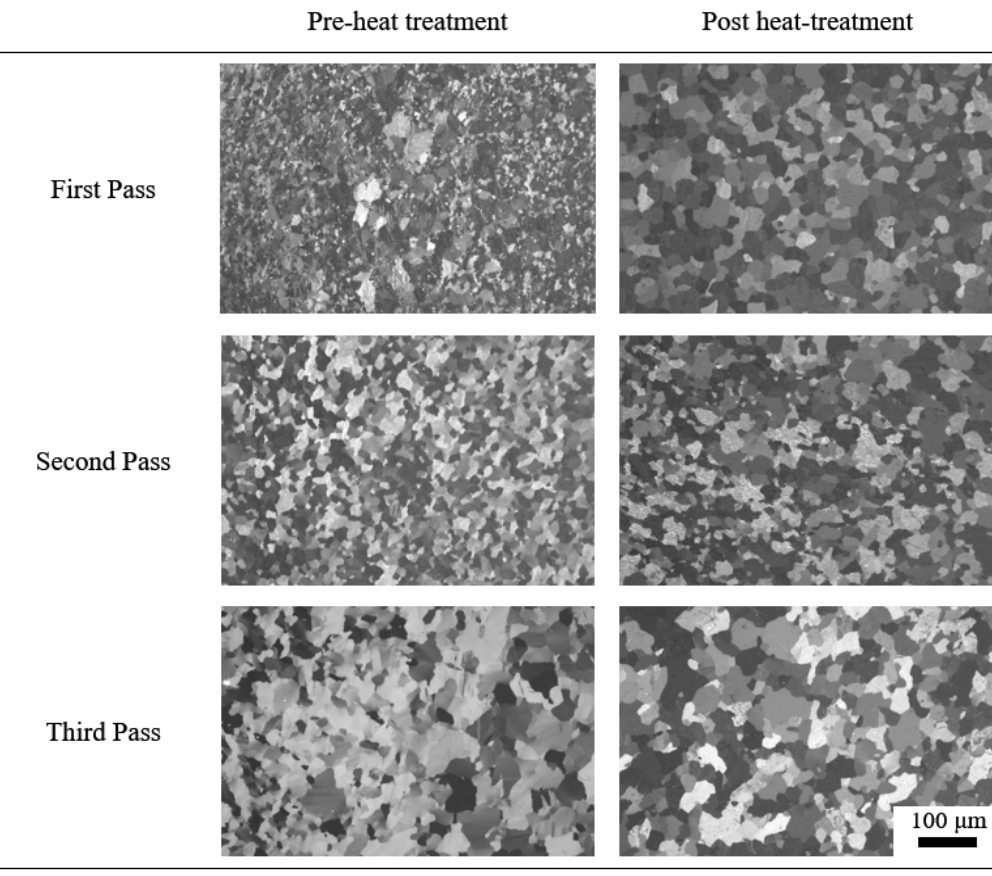
Figure 16. Polarised light micrographs of the cold-drawn CP-Ti Gr 2 wire cross-section after each pass, before and after heat treatment. The first pass reduction was from 5.00 to 4.09 mm, second pass from 4.09 to 3.50 mm and third pass from 3.50 to 3.00 mm.